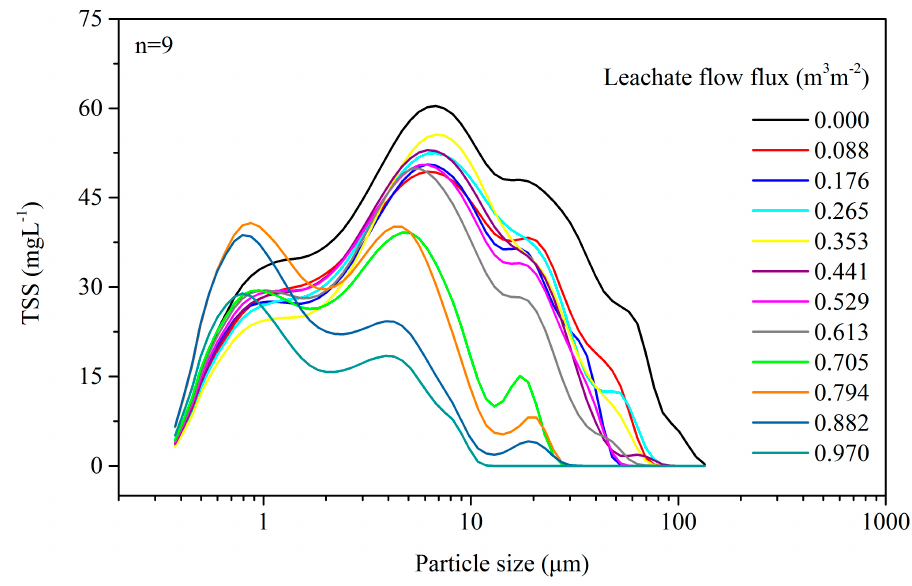
Figure 2. Particulate matter sizes and concentrations in leachate under different filtration fluxes.